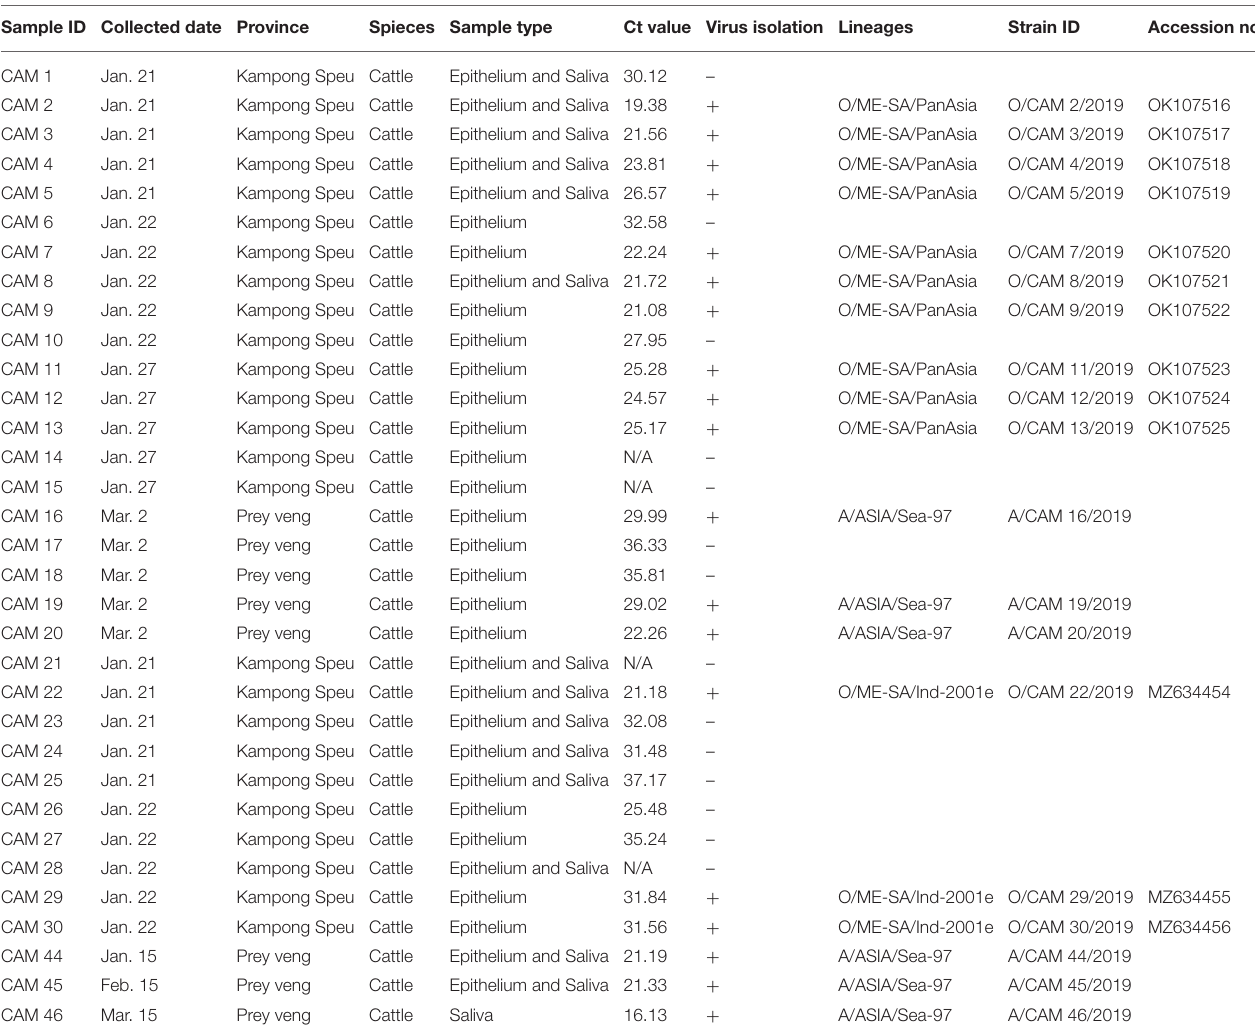
TABLE 1 | Outbreaks and diagnosis FMD in Cambodia (January–March 2019). Sample ID Collected date